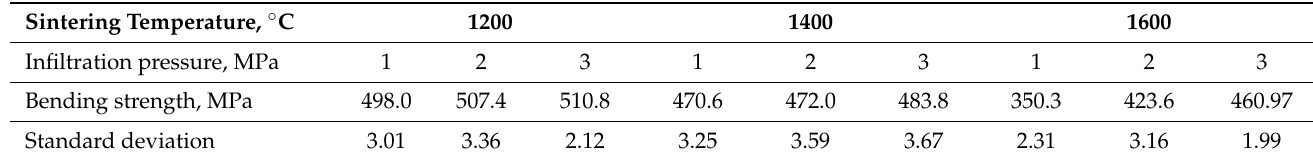
Table 3. Results of the bending strength test on the produced composite